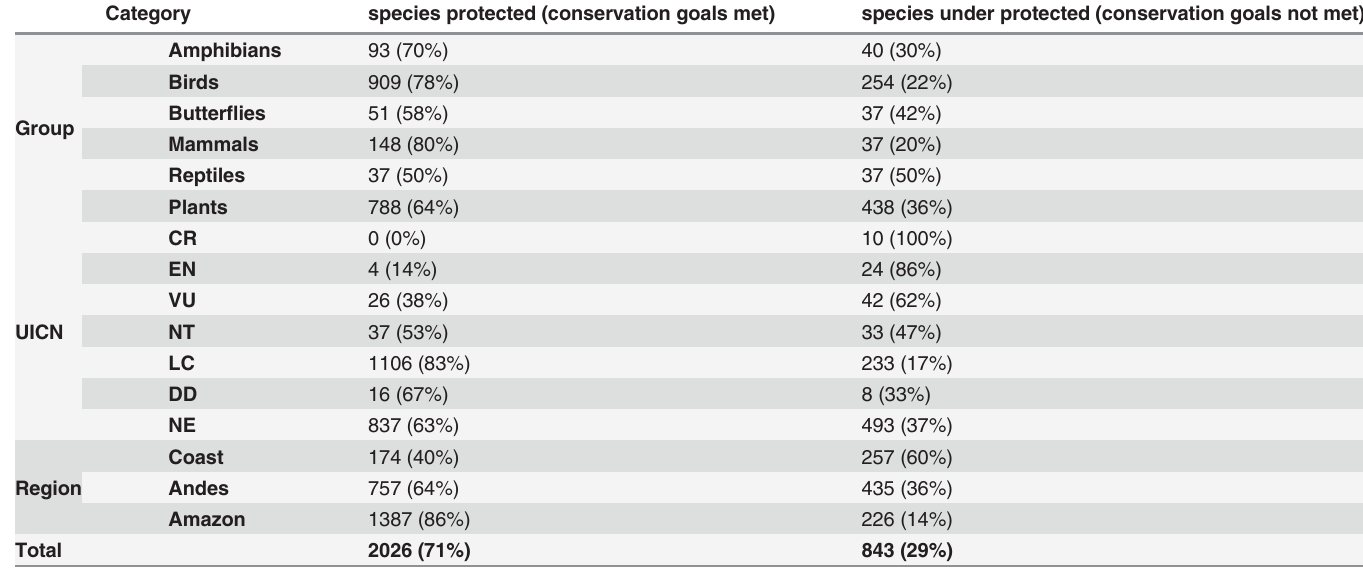
Table 2. Species representation in the current protected area network of continental Peru based on the conservation goals de fi ned in this study. Results are classi fi ed by taxonomic group, IUCN category and region. Category species protected (conservation goals met) species under protected (conservation goals not met) Amphibians 93 (70%) 40 (30%) Group